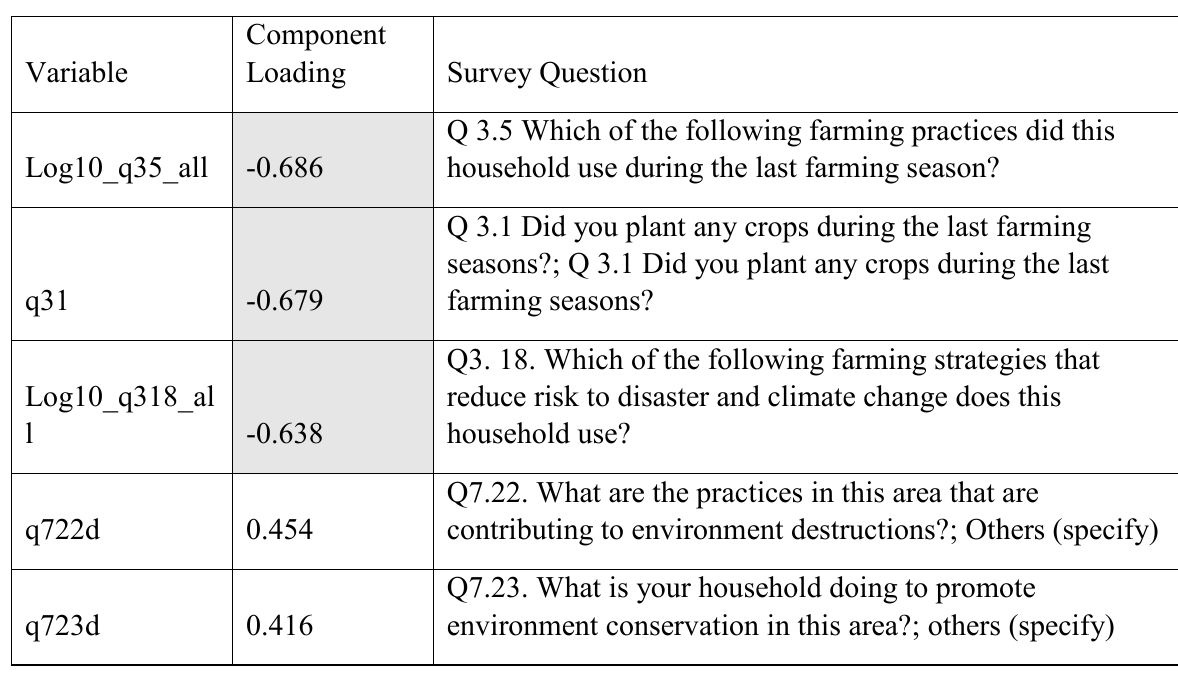
Table 1.28: Variables defining Adaptive Resilience PC3